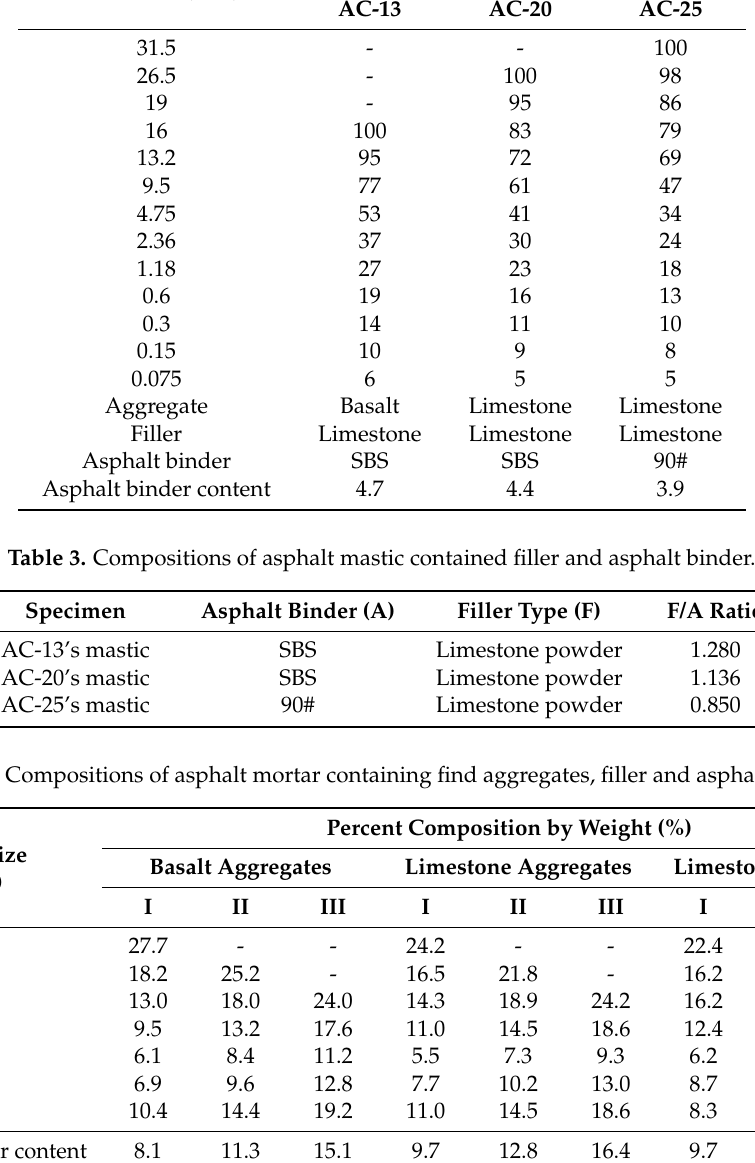
Table 2. Aggregate grading and compositions of various asphalt mixtures.